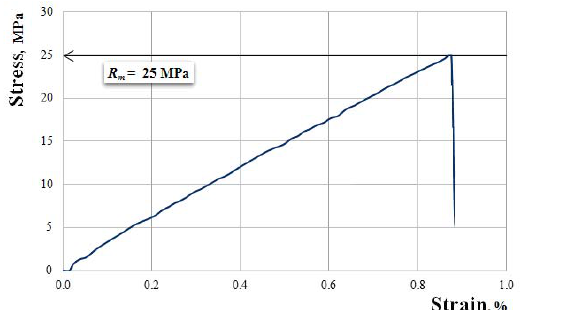
Figure 14. The characteristic curve of a representative sample of cattail leaves-reinforced composite